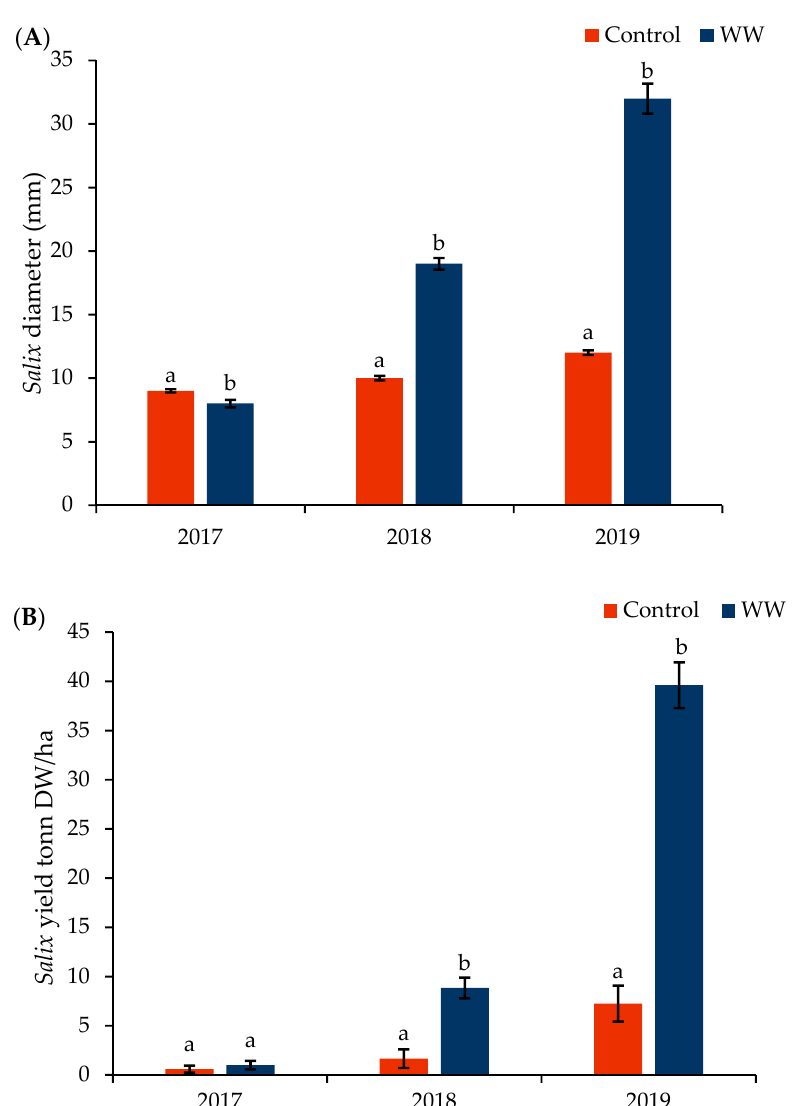
Figure 3. Willow diameter growth ( A ) and total dry biomass production ( B ) in three years once exposed to WW irrigation in the field (mean ± SE). Diameter (n = 30) and yield were analyzed using ANCOVA for treatment. Different small letters represent the significant difference between treatments at p < 0.05 using Tukey’s HSD test.